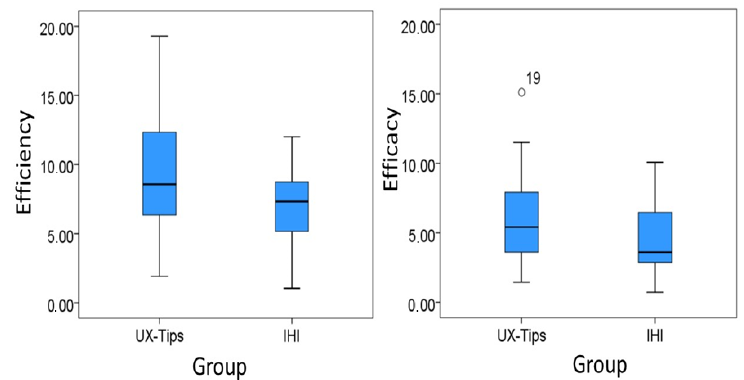
Figure 5. Boxplots for efficiency and